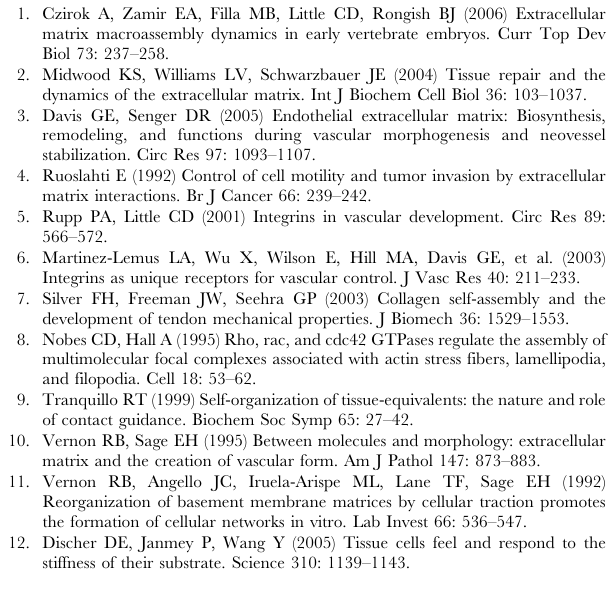
Figure S1 Cell elongation. For a different parameter set, fewer cells are recruited from the parent vessel and cells elongate. Here cells are approximately 40 m m in length and the average extension speed at 14 hours is 6.8 m m/hr. J {ee,em,ef} ={42,76,66}, x tip = 1.55 x , x x . {stalk, prolif} =1.45 Found at: doi:10.1371/journal.pcbi.1000445.s001 (2.30 MB TIF) Figure S2 Our model accurately captures the cellular response to topographical guidance (no VEGF) on patterned substratum. Compare this image with morphological data of fibroblasts stained for actin and tubulin showing that cells alter their shape, orientation, and polarity to align with the direction of the grooves [see Figure 5e,f from Oakley et al. 1997]. Simulation is on similarly patterned substrate and demonstrates the flexibility of our model to capture a variety of different morphological